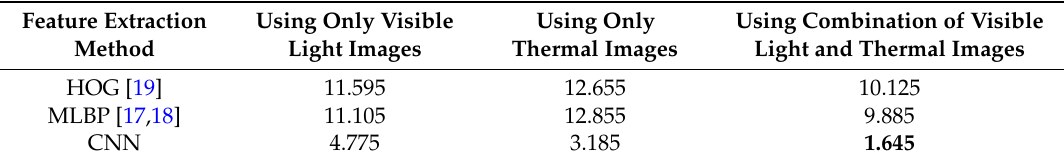
Table 6. The verification accuracy (EER) of the recognition system using correlation distance without applying PCA on extracted image features (unit: